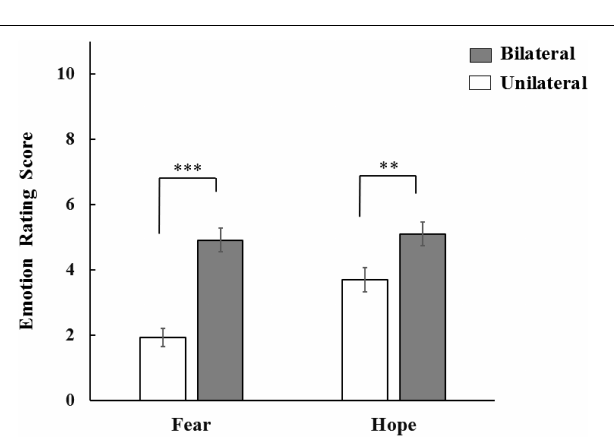
FIGURE 2 | The effect of bilateral/unilateral condition on fear and hope; error bars depict standard errors; ** p < 0.01 and *** p < 0.001.